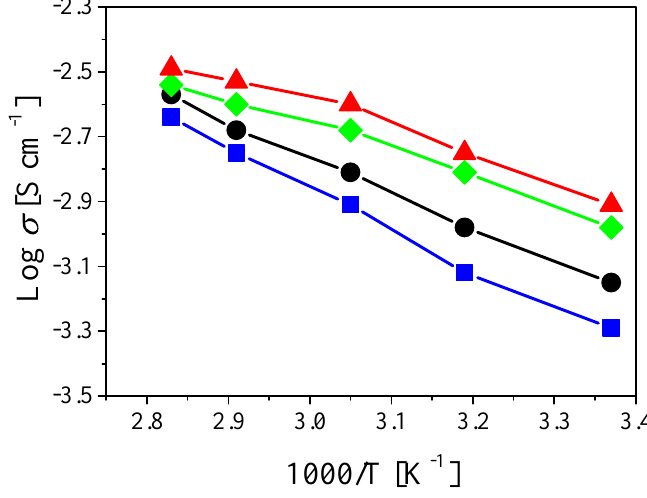
Figure 5. Ionic conductivity at 25, 40, 55, 70 and 80 ◦ C of the PSiCIL membranes containing 70 wt.% of IL and 0% (blue squares) [44], 5% (green diamonds), 10% (red triangles), and 15% (black circles) of SiO 2 ,